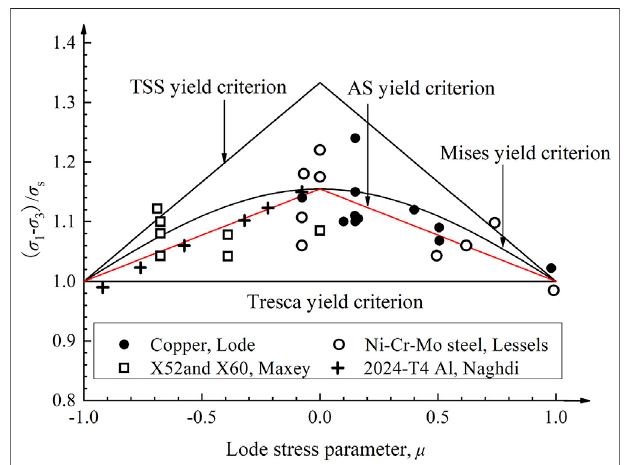
FIGURE 4 | Comparison of various yield criteria and experimental